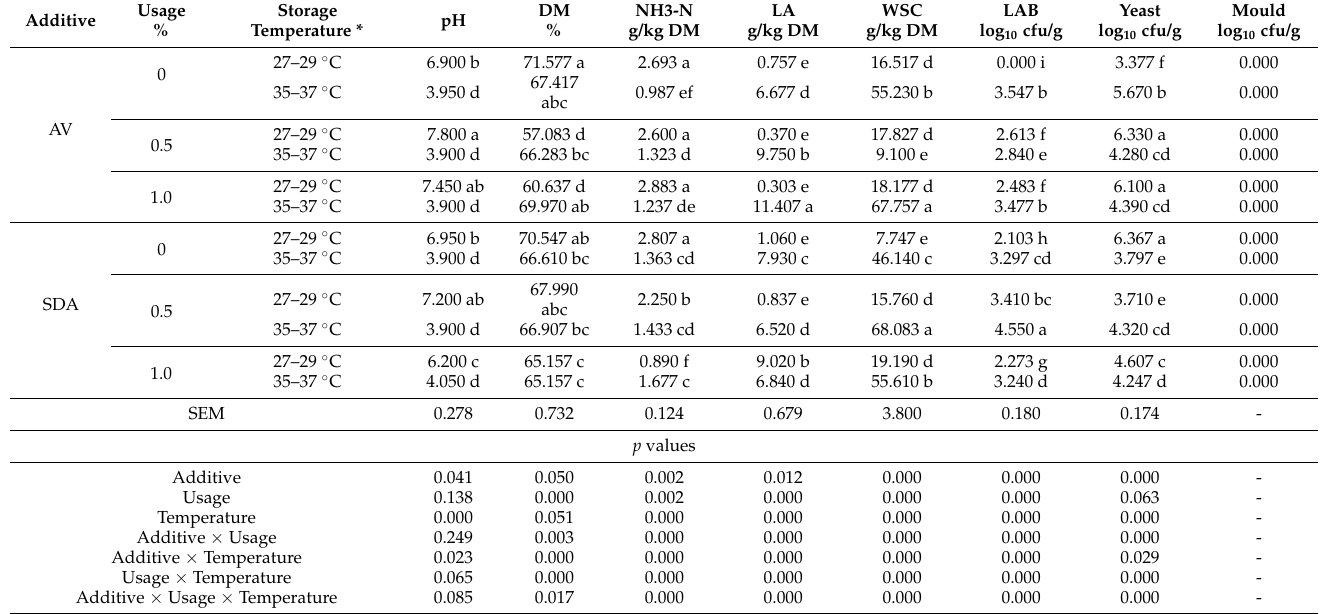
Table 5. Effects of additives and storage conditions on the 12th day of aerobic stability of high moisture maize